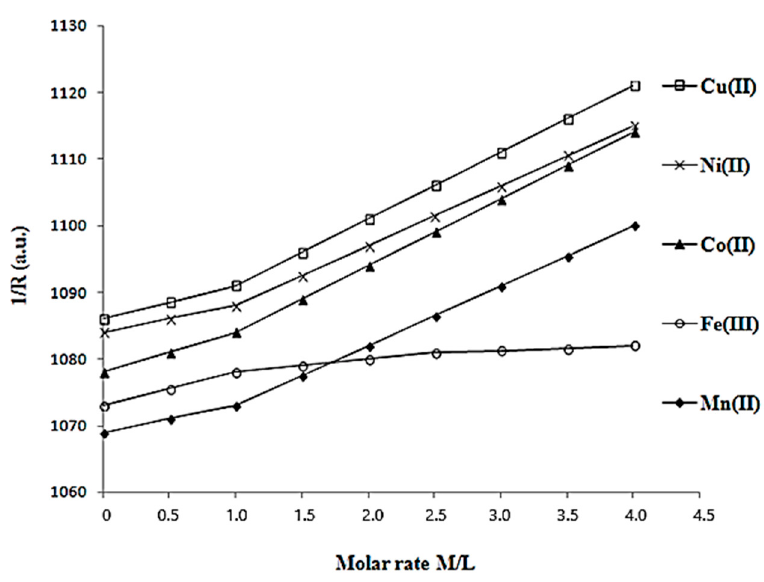
Figure 2. Determination of the molar combination ratio between monolacunary ligand L and metal cations M (Mn 2+ , Fe 3+ , Co 2+ , Ni 2+ , and Cu 2+ ) in a buffer solution at pH 5.0 using the conductometric method.